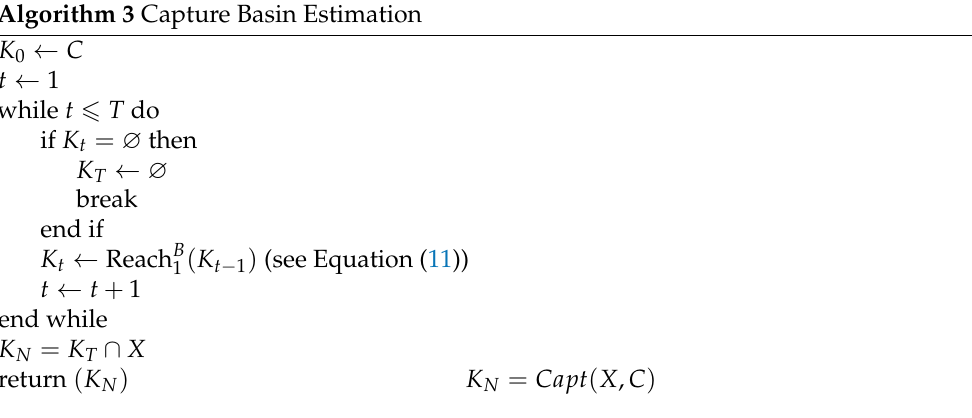
Algorithm 3 Capture Basin